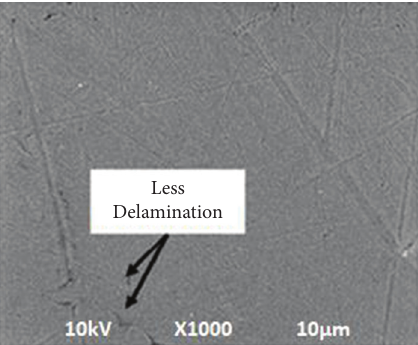
Figure 13: SEM micrograph of worn untreated polypropylene-graft-maleic anhydride (U +PP+MAPP) sample at different loading conditions.